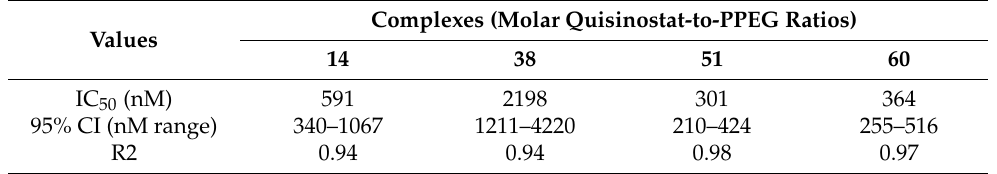
Table A2. IC 50 values of quisinostat–PPEG complexes in A549 NSCLC cells (72 h): IC 50 values calculated on the basis of quisinostat concentration.